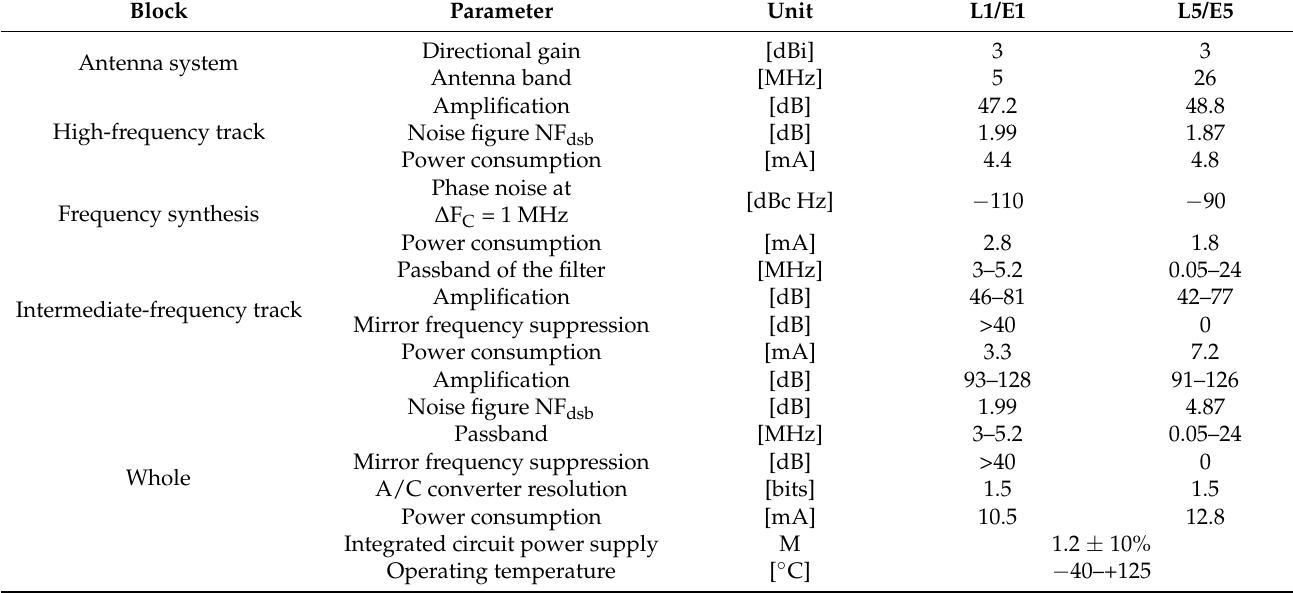
Table 1. Main parameters of the GNSS receiver of the Galileo constellation and GPS for the bands L1/E1 and L5/E5. Block